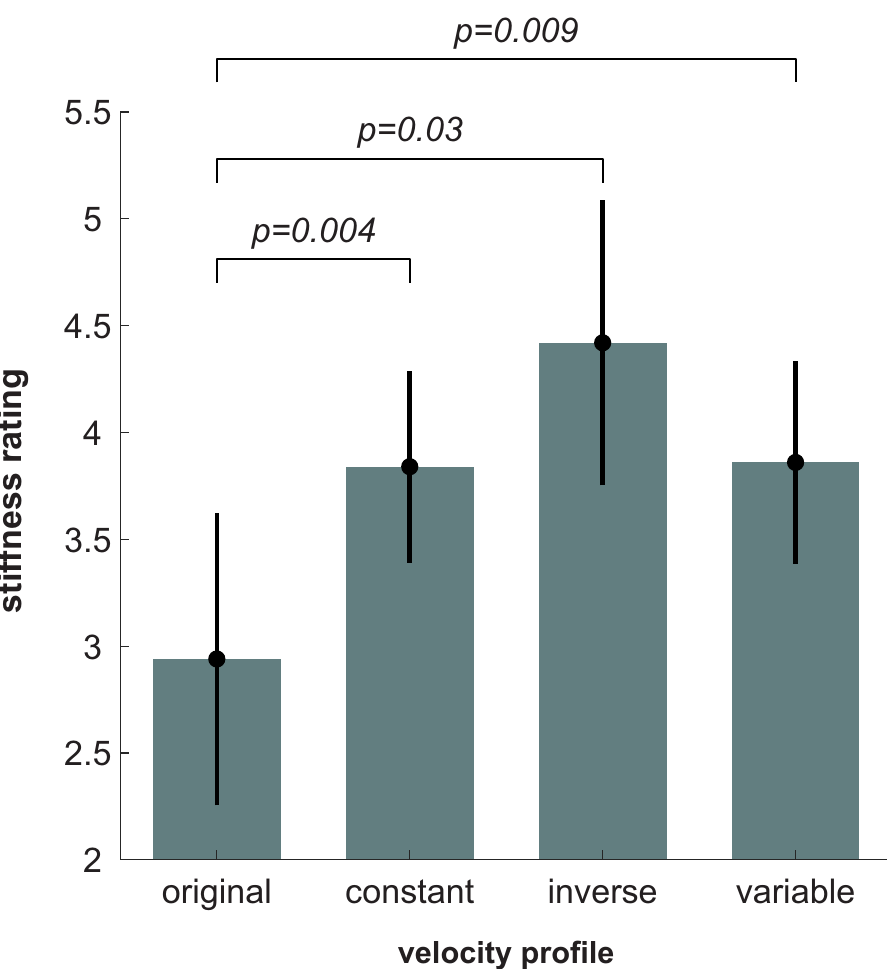
Fig 10. Experiment 2 stiffness estimate results. A significant effect of velocity profile on stiffness estimate was observed. Stiffness estimates for the original velocity profiles were statistically smaller than for the manipulated velocity profiles. There was no statistical difference in stiffness estimate between the three manipulated velocity profiles. Bars show the average arm stiffness estimate across subjects for each velocity profile. Error bars represent ± 2 standard errors of the